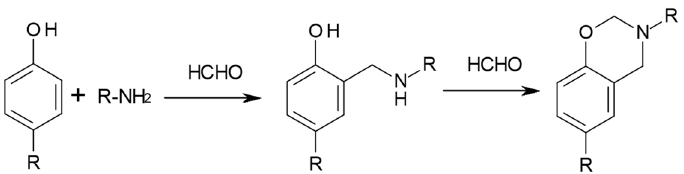
Figure 1. Scheme of Mannich base synthesis reaction.